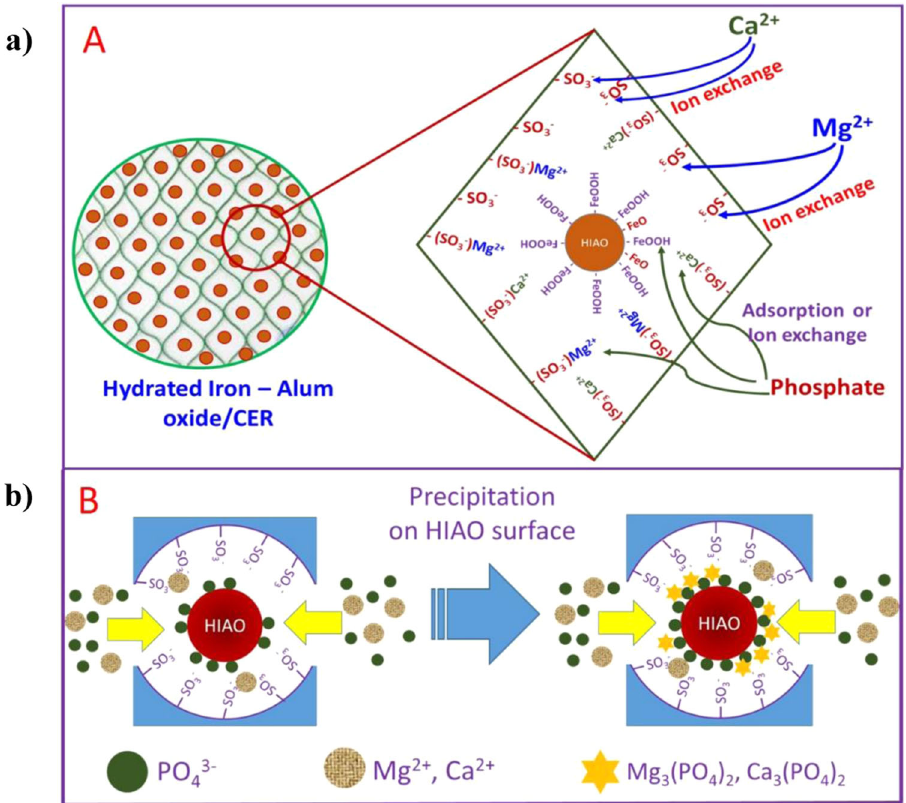
Fig. 5 Illustrations of simultaneous adsorption and precipitation of HIAO/225H material. a Simultaneous adsorption of phosphate and hardness; b precipitation of Ca 3 (PO 4 ) 2 và Mg 3 (PO 4 ) 2 on HIAO surface of HIAO/225H